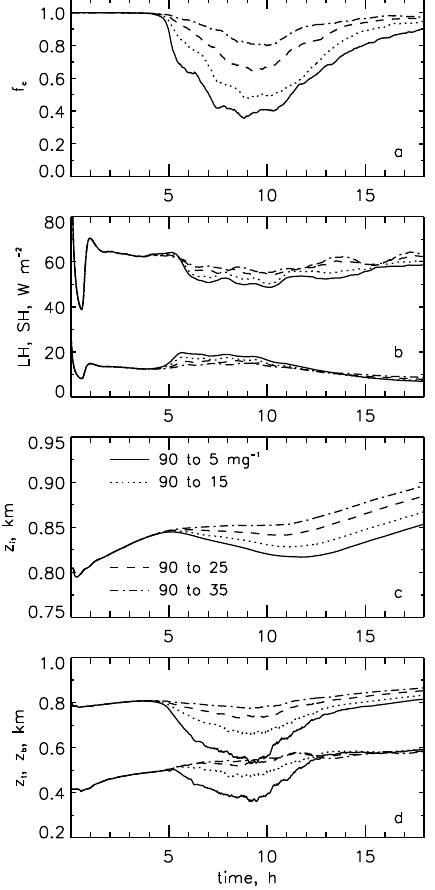
Figure 4. Time series of (a) cloud fraction f c , (b) surface latent and sensible heat fluxes (LH and SH, respectively; LH > SH), (c) inver- sion height z i , and (d) cloud top z t and cloud base z b for the control case and the various minimum N as in Fig. 1. Note the suppression of the deepening of the boundary layer associated with